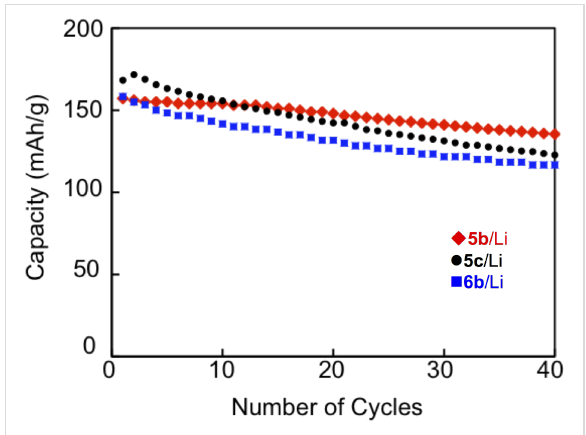
Figure 7: Cycle-life performances for 5b /Li, 5c /Li and 6b /Li cells.